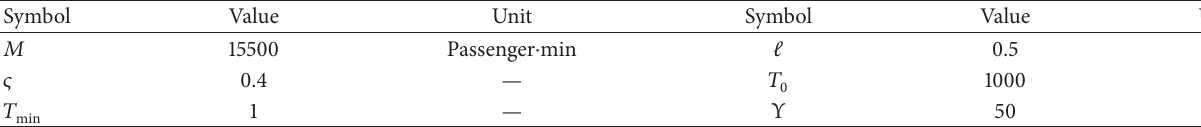
Table 2: Parameter values of algorithm.